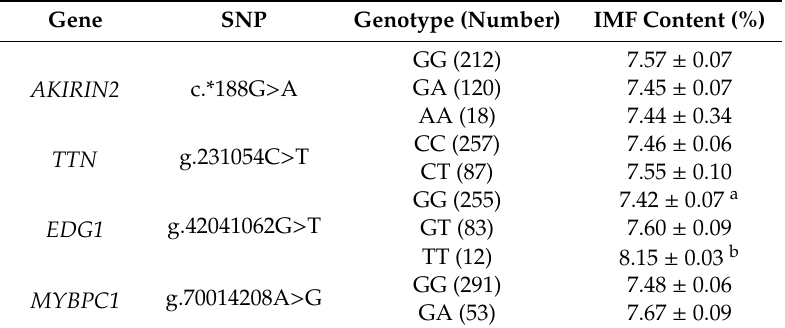
Table 1. Association of single nucleotide polymorphisms (SNPs) in the AKIRIN 2, TTN , EDG1 and MYBPC1 genes with IMF content in Qinchuan cattle.